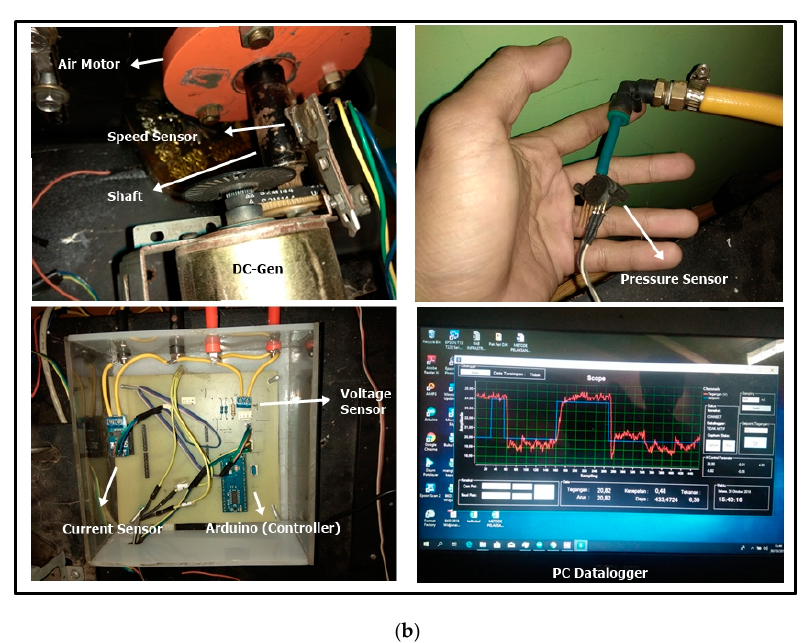
Figure 2. ( a ) The main components of prototype SS-CAES; and, ( b ) The installed sensor, controller on prototype SS-CAES and PC data logger.